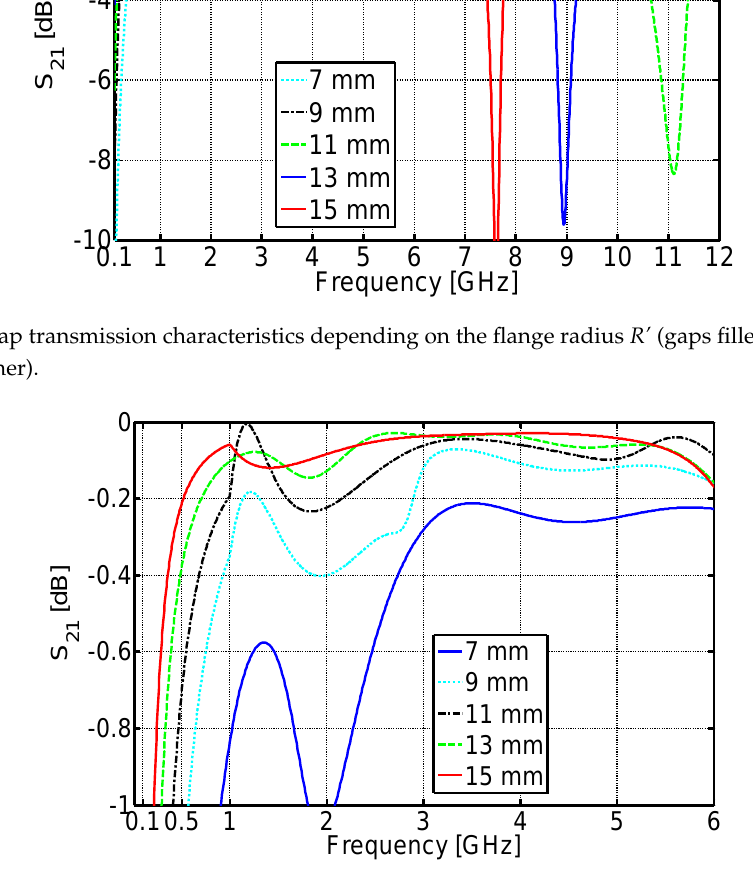
Figure 6. Detailed simulation of gap transmission characteristics (depending on flange radius R ’) in frequency and amplitude values of interest (gaps filled with polyethylene) .